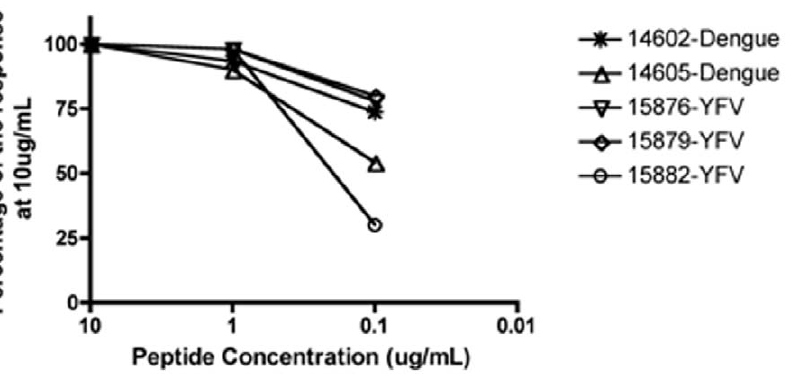
Figure 1. Schematic diagram of the epitope discovery scheme. In addition to the 237 good binders, 5 weak binders and one non-binder was also tested in this study for comparison, but these are not included in the